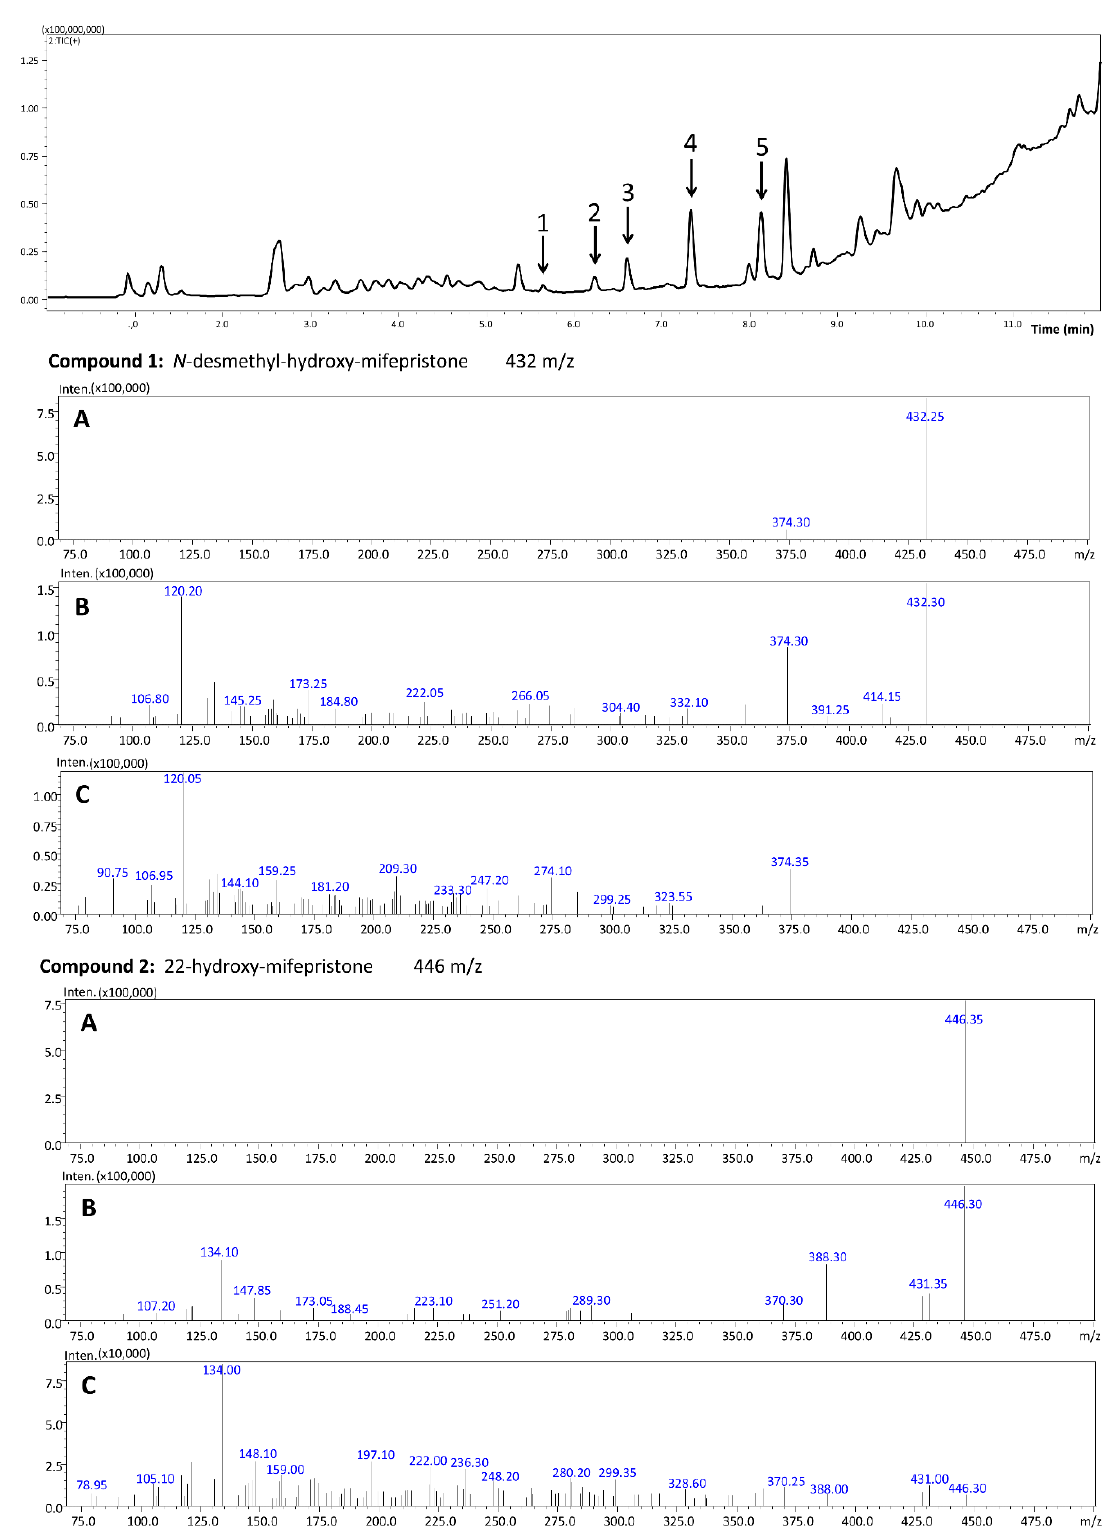
Figure 3. Total ion chromatogram (TIC) of mifepristone and metabolites in blood extract ( top ) and product ion spectra for N -desmethyl-hydroxy-mifepristone (precursor ion: 432 m / z ) and 22-hydroxy- mifepristone (precursor ion: 446 m / z ) at three collision energies ( A ) − 10 V; ( B ) − 20 V and ( C ) − 35 V.